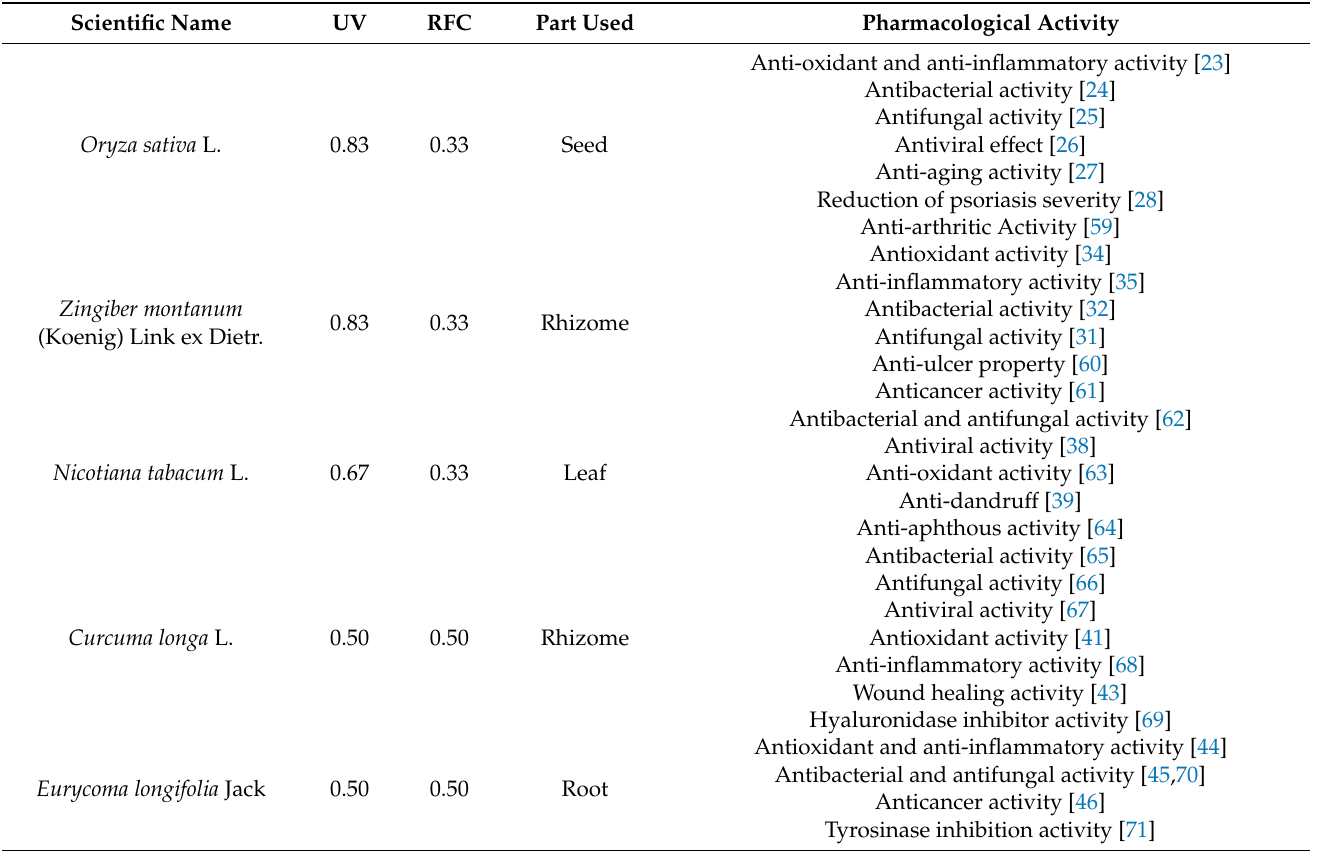
Table 4. Preferred plants used in polyherbal remedies for skin diseases and their pharmacological